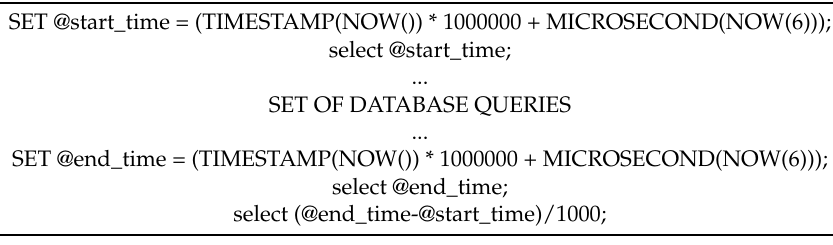
Table 12. The code for calculating the speed of execution of database